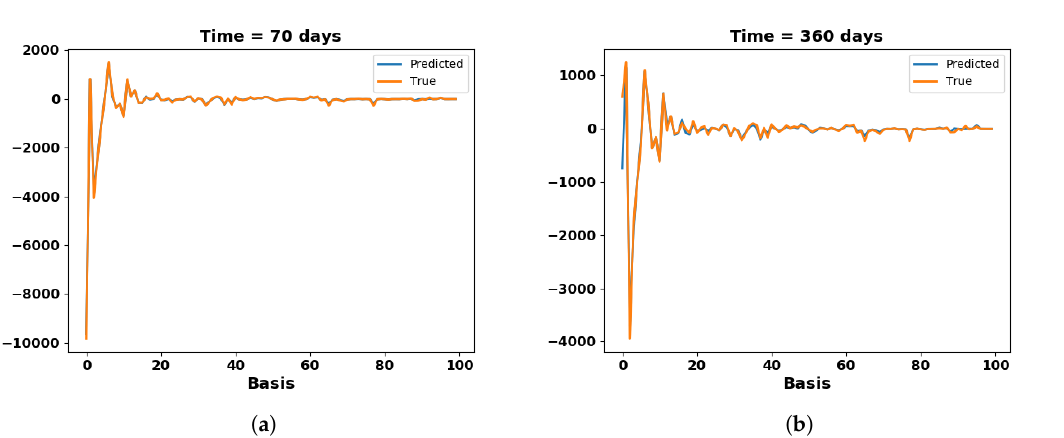
Figure 18. True and ML predicted pressure basis coefficient comparison at time = ( a ) 70 days and ( b ) 360 days.